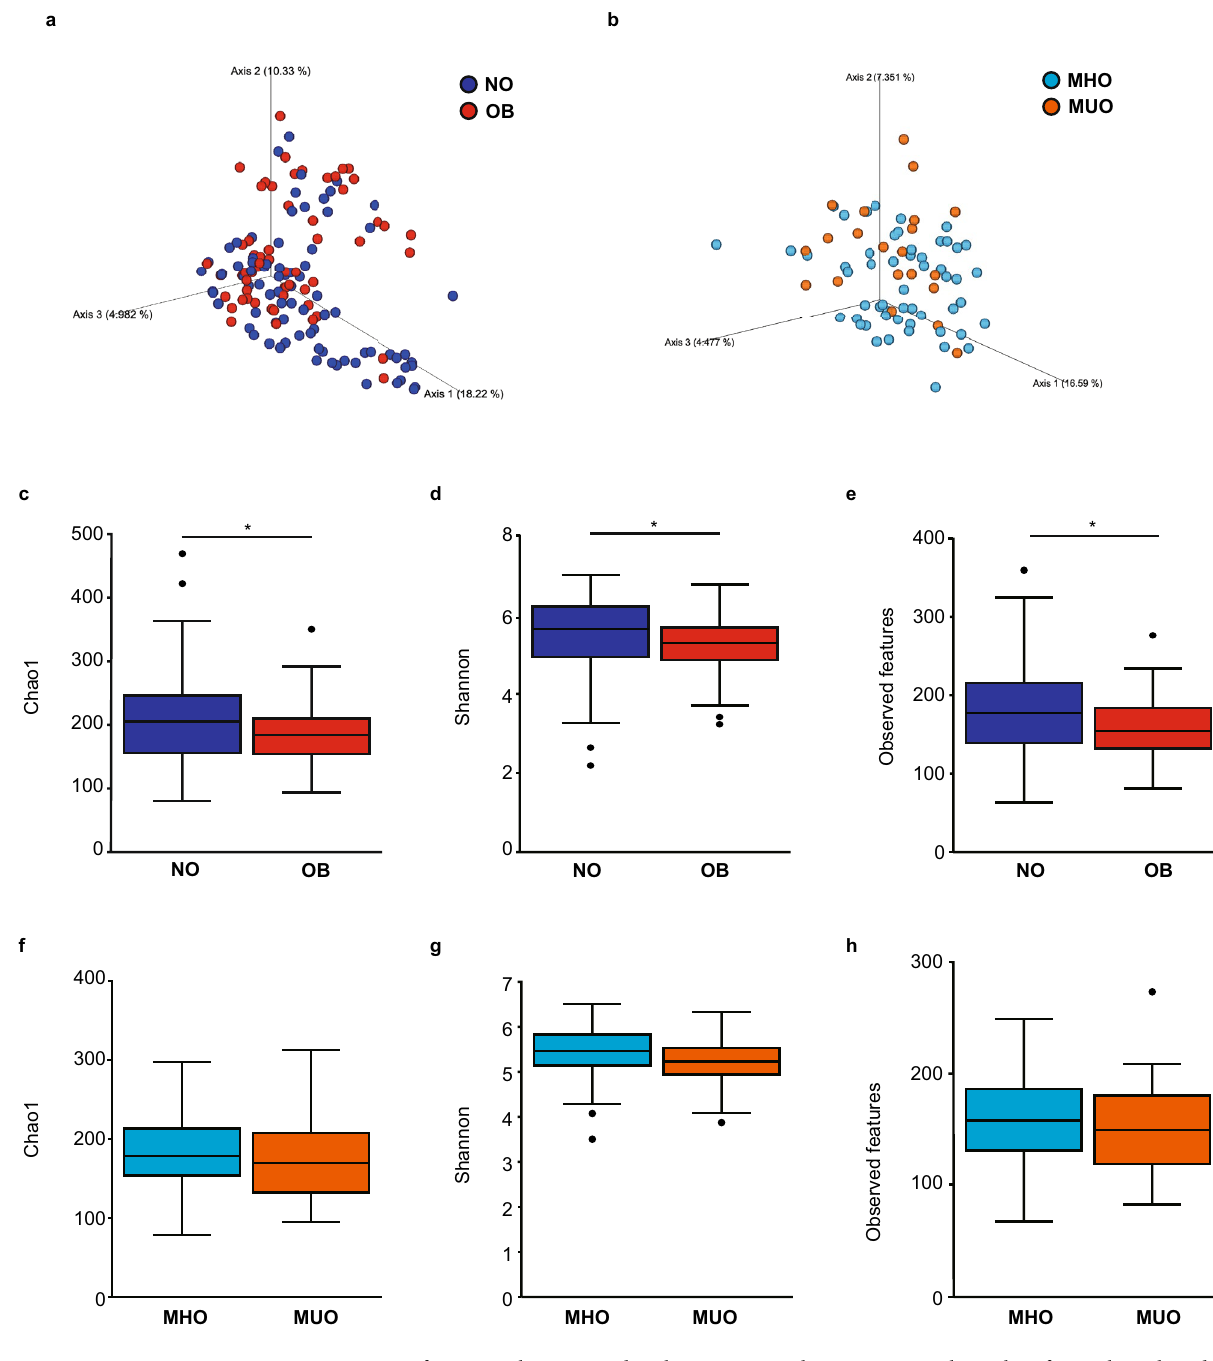
Figure 2. Diversity of gut microbiota in study subjects. Principal component analysis plot of microbiota based on unweighted UniFrac distances showing beta diversity in ( a ) NO and OB, and ( b ) MHO and MUO with permutational multivariate analysis of variance (PERMANOVA) employed to compare differences between groups. Alpha diversity was measured using Chao1, Shannon and Observed features indices to compare NO and OB ( c–e ), and MHO and MUO ( f–h ), with the Kruskal–Wallis test used to calculate the level of significance between groups. NO; non-obese (blue) (n = 81), OB; obese (red) (n = 59), MHO; metabolically healthy obese (light blue) (n = 54) and MUO; metabolically unhealthy obese (orange) (n = 21). Graphics were made using the QIIME2 (version: 2019.7). * p <